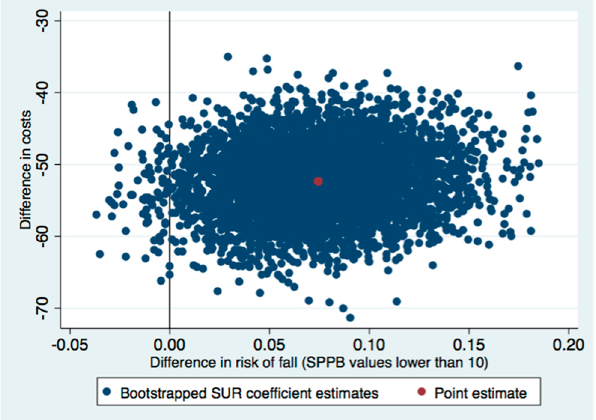
Figure 4. Cost-effectiveness plane for risk of fall using the SPPB Test. SUR: seemingly unrelated regression.